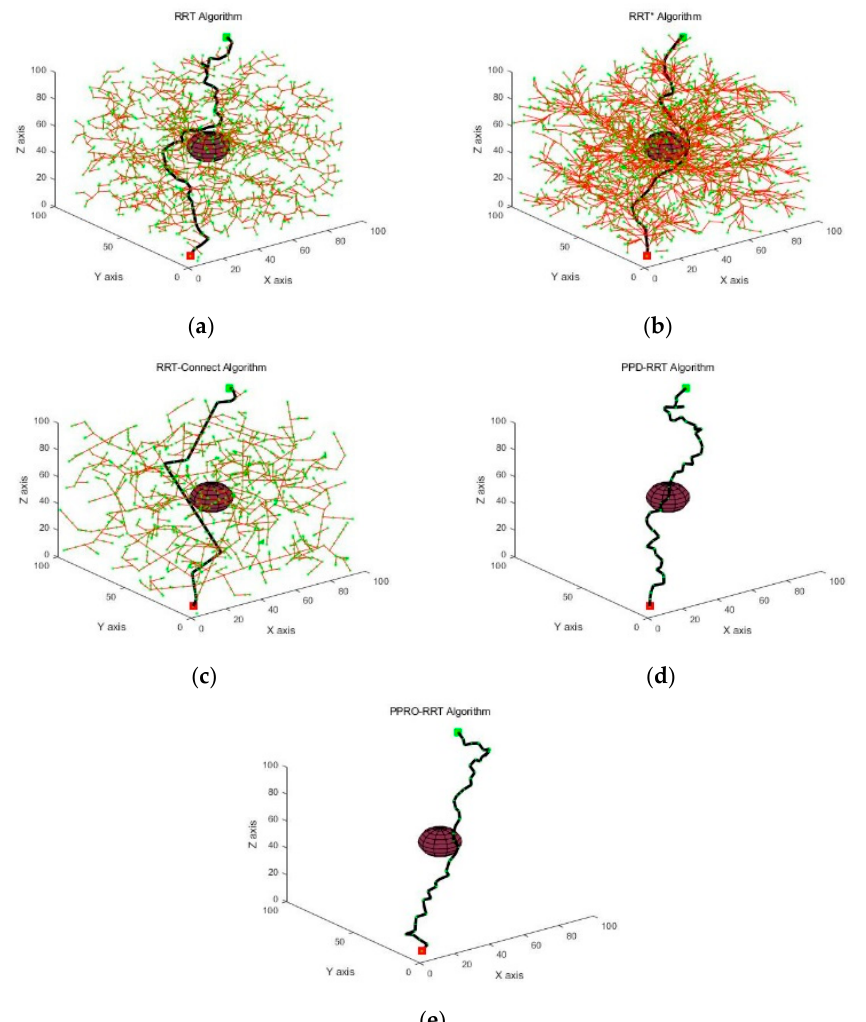
Figure 4. Paths planned by various algorithms in a simple environment. The red cube indicates the starting position and the green cube indicates the target position. The red sphere indicates the obstacles in the environment, the green dot indicates the points obtained by sampling during the path planning process, the red solid line indicates the branches of the random tree, and the black solid line indicates the feasible paths obtained. ( a ) RRT algorithm; ( b ) RRT* algorithm; ( c ) RRT-Connect algorithm; ( d ) PPD-RRT algorithm; ( e ) PPRO-RRT algorithm.